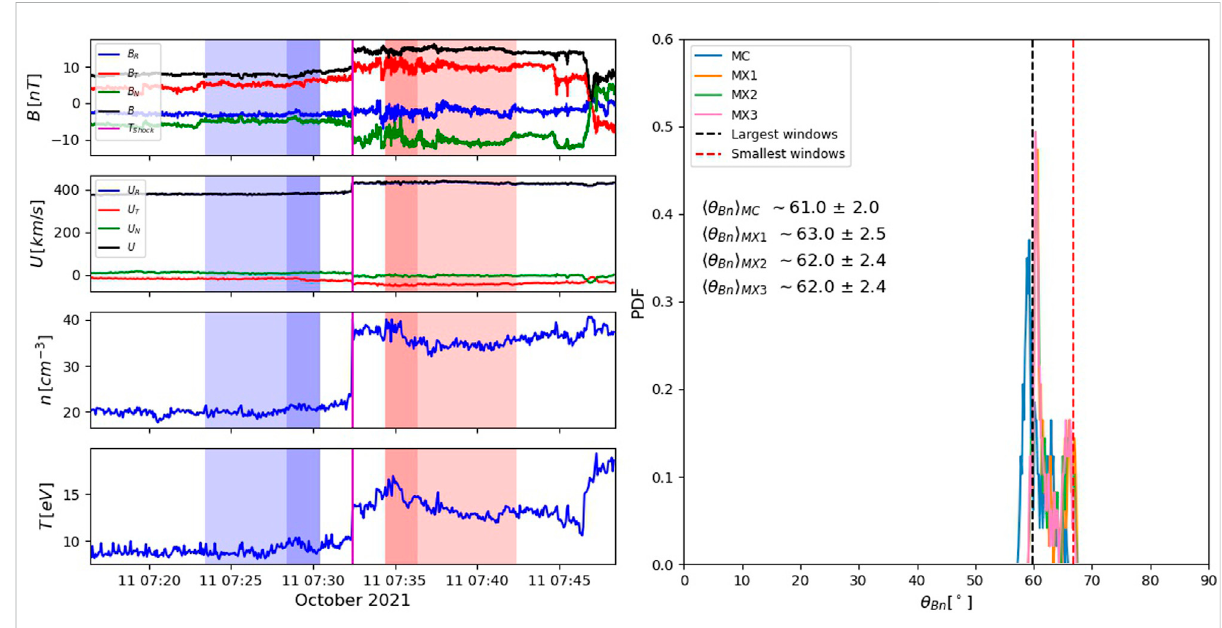
The quiet event of 11 October 2021 seen by Solar Orbiter. The left-hand panels show magnetic fi eld B , ion bulk fl ow U , ion density n and temperature T measured by the MAG and SWA instruments. Vector quantities are shown in the RTN coordinate system. The blue/red shaded panels show the smallest (dark) to largest (lighter) averaging windows in the upstream/downstream regions. The vertical purple line shows the shock crossing time. The right-hand side panel shows thePDF distributionof θ Bn values obtained for this event, with the vertical red (blue) dashed line showing the parameter esimation using the smallest (largest) window choice. The average values of θ Bn obtained with each technique are also